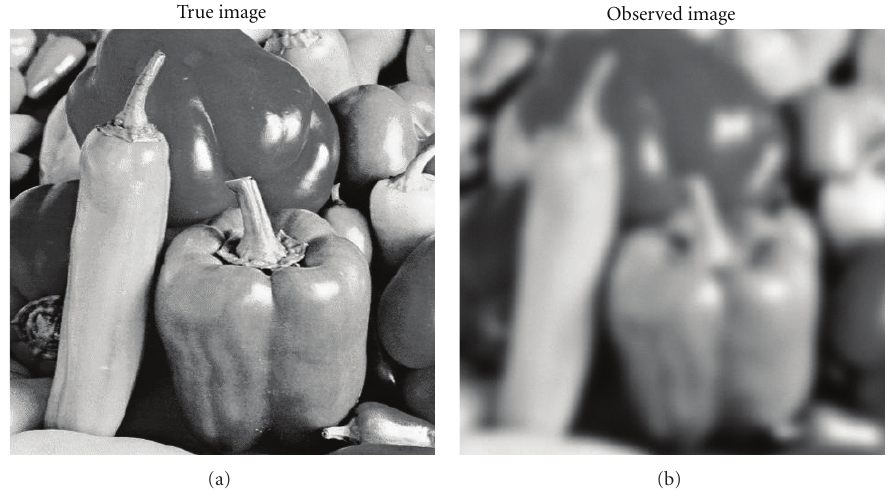
Figure 1: Test problem with Gaussian blur and 1% white Gaussian noise.